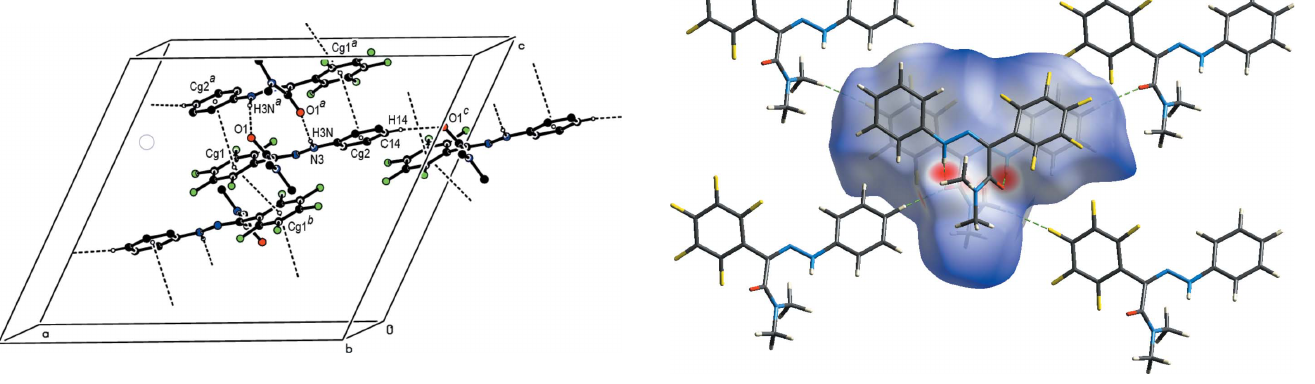
Figure 2 View oblique to [010] of the intermolecular N—H (cid:3)(cid:3)(cid:3) O, C—H (cid:3)(cid:3)(cid:3) O and (cid:2) – (cid:2) stacking interactions of the title compound.